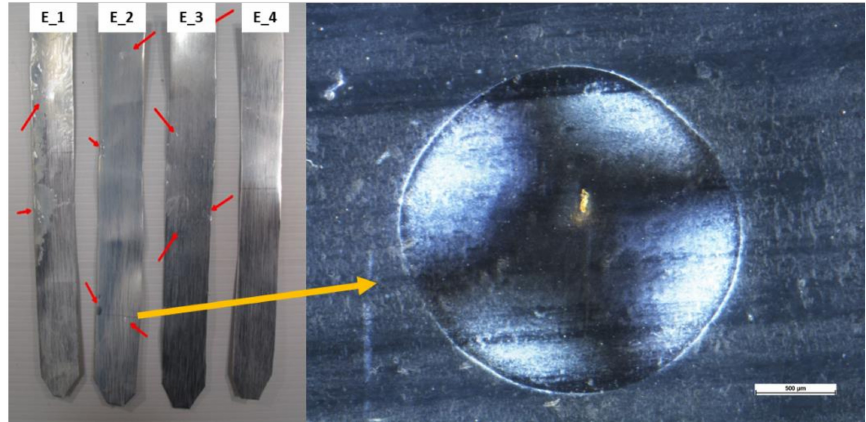
Figure 3. Samples E, where the red arrows indicate the presence of bubbles. On the right, the magnification of one of these bubbles is shown.